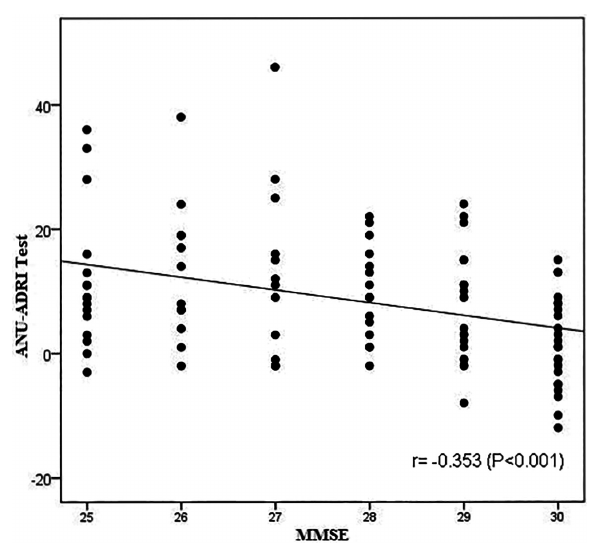
Figure 5. Dispersion plot of ANU-ADRI and MMSE